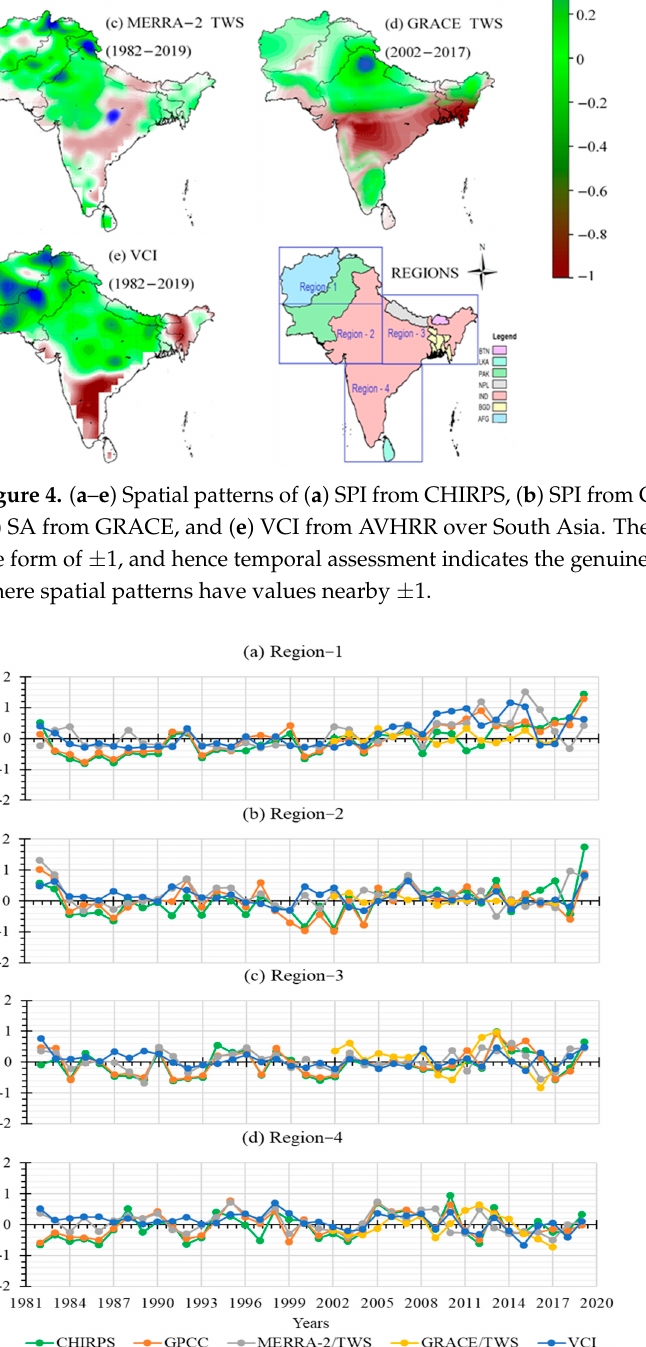
Table 3. Geographical coverage of study region. Regions